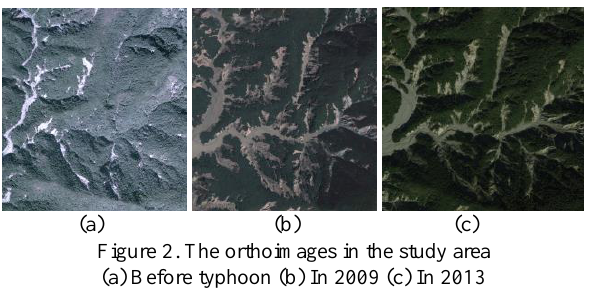
Figure 2. The orthoimages in the study area